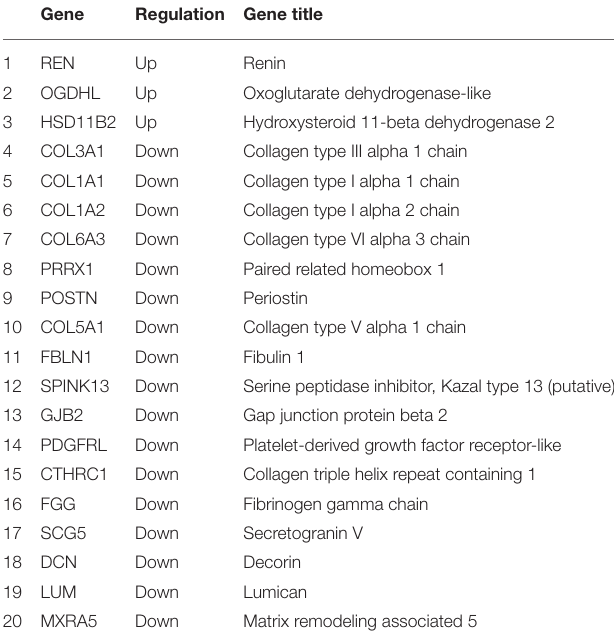
TABLE 2 | The shared DEGs of the GSE105261 and GSE85258